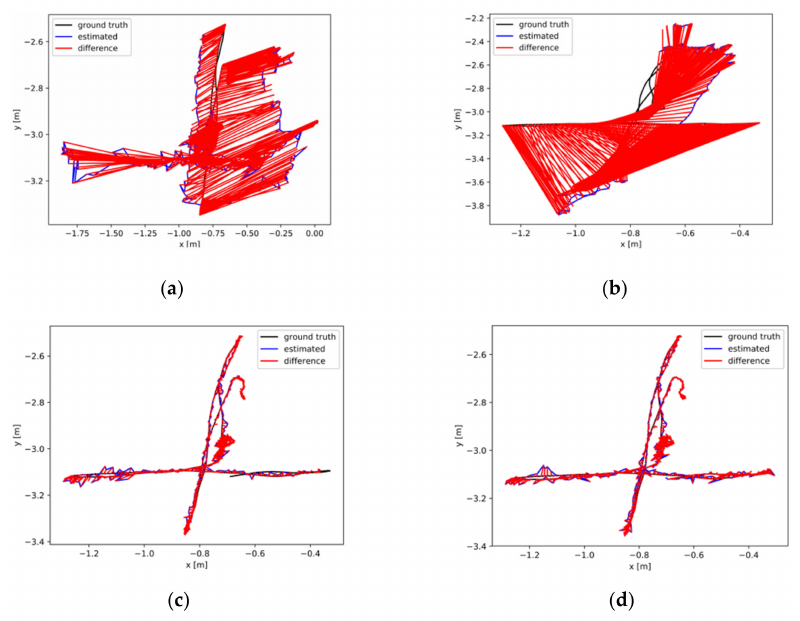
Figure 11. Comparisons of ATE-RMSE on the high dynamic sequences” fr3_walking_xyz ”. ( a ) OPF- SLAM; ( b ) ORB-SLAM2;( c ) Dyna-SLAM; ( d )